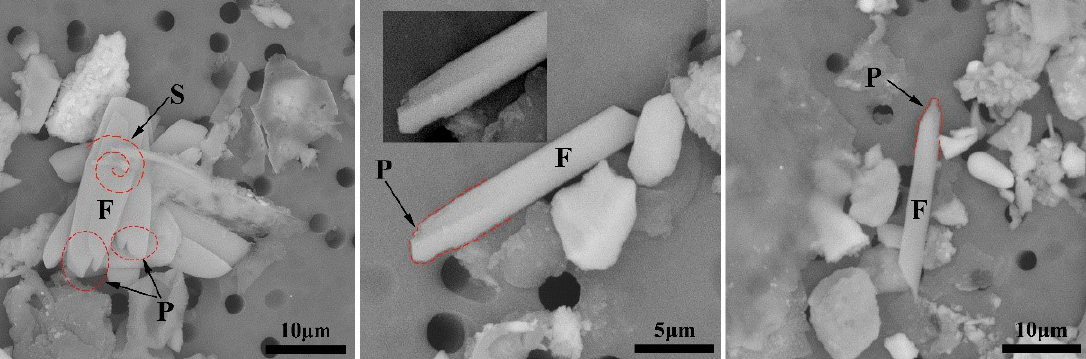
Figure 12. The morphologies of CaS inclusion at S content of 0.001%. F: flat interface; P: polyhedral morphology; S: spiral growth.